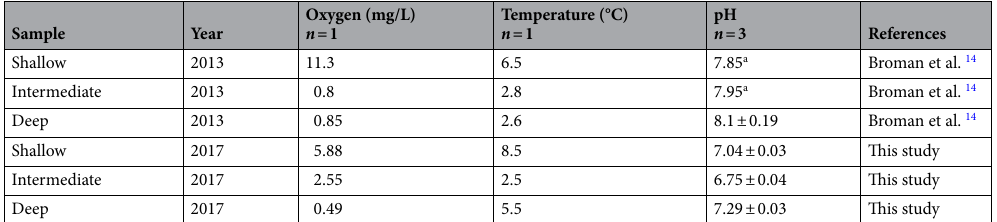
Table 1. Oxygen, temperature, and pH in 2013 and 2017. Overview of in situ oxygen and temperature in bottom waters in 2013 and 2017 at each sampling site as well as pH measured for bottom waters for both years and all sites in triplicates; mean ( n = 1 or 3 as indicated) ± standard deviation. a n =